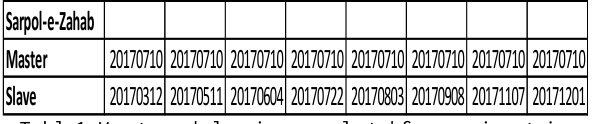
Table 1: Master and slave images selected for experiments in